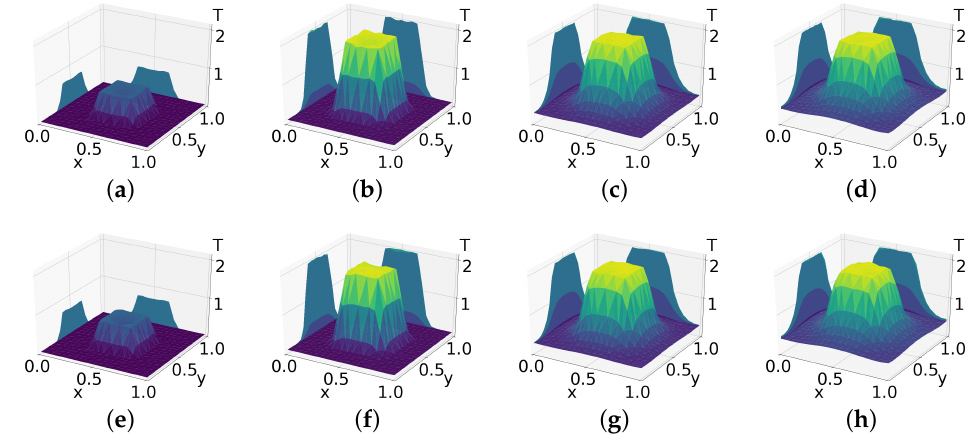
( t , x ) , ξ , t , x )] of optimal control on the first Figure A1. Mean temperature realizations E [ T ∗ ( u ∗ ( 0, H ] prediction horizon by τ = 0.001; ( a ) OA , t = 0.025; ( b ) OA , t = 0.2; ( c ) OA , t = 1.0; ( d ) OA , t = 2.0; ( e ) IA , t = 0.025; ( f ) IA , t = 0.2; ( g ) IA , t = 1.0; ( h ) IA , t =